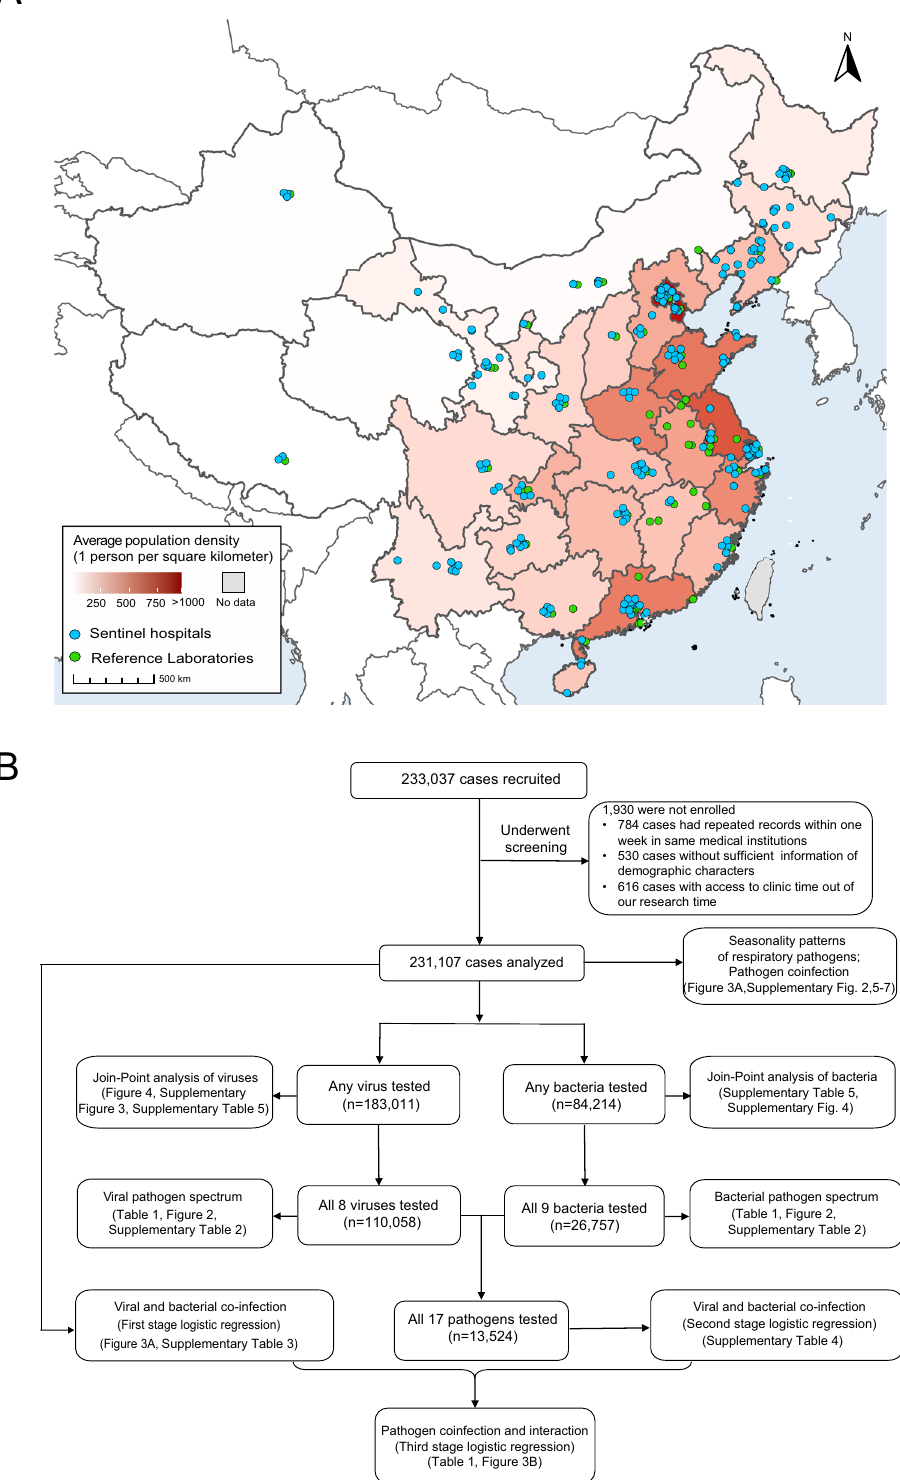
Fig. 1 Setting of hospital-based surveillance network and data processing in the mainland of China. A Locations of the 277 sentinel hospitals and the 92 reference laboratories participating in acute respiratory infection (ARI) surveillance from 2009 to 2019. Each point indicates the location of a sentinel hospital (blue) or laboratory (green). The black lines indicated the province boundaries. The background color indicates the average population density of each province from 2009 to 2019 in China. B Flowchart of data collection and sorting